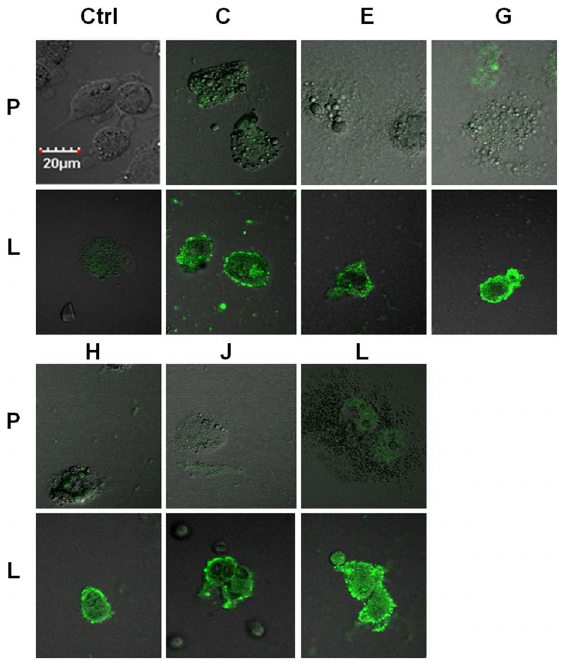
Figure 3. Immunofluorescence microscopy of phage clones from round 3 of panning. Randomly selected PSMA-targeted phage clones (C, E, G, H, J, L) from the third round of screening bound specifically to LNCaP cells (‘‘L’’), but not PC3 cells (‘‘P’’). While staining was preferentially bound at cell surface, there was evidence of internalization (scale 20 m m).